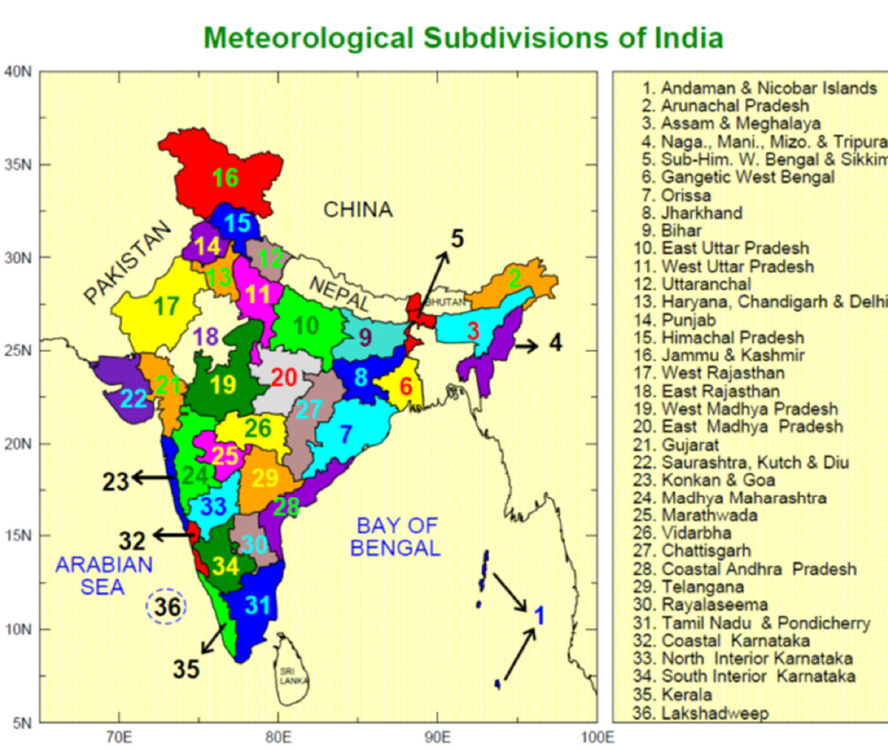
Figure 2. Thirty ‐ six meteorological subdivisions of India. Figure 2. Thirty-six meteorological subdivisions of